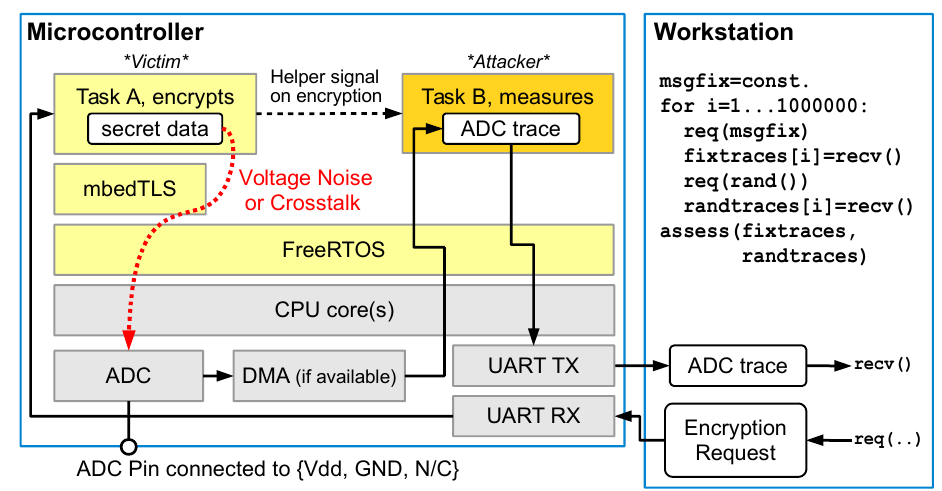
Figure 2: Overview of our common experimental setup, shared among the used